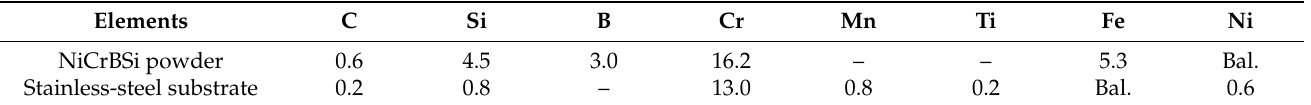
Table 1. Chemical compositions of NiCrBSi powder and stainless-steel substrate (in wt%). Elements C NiCrBSi powder